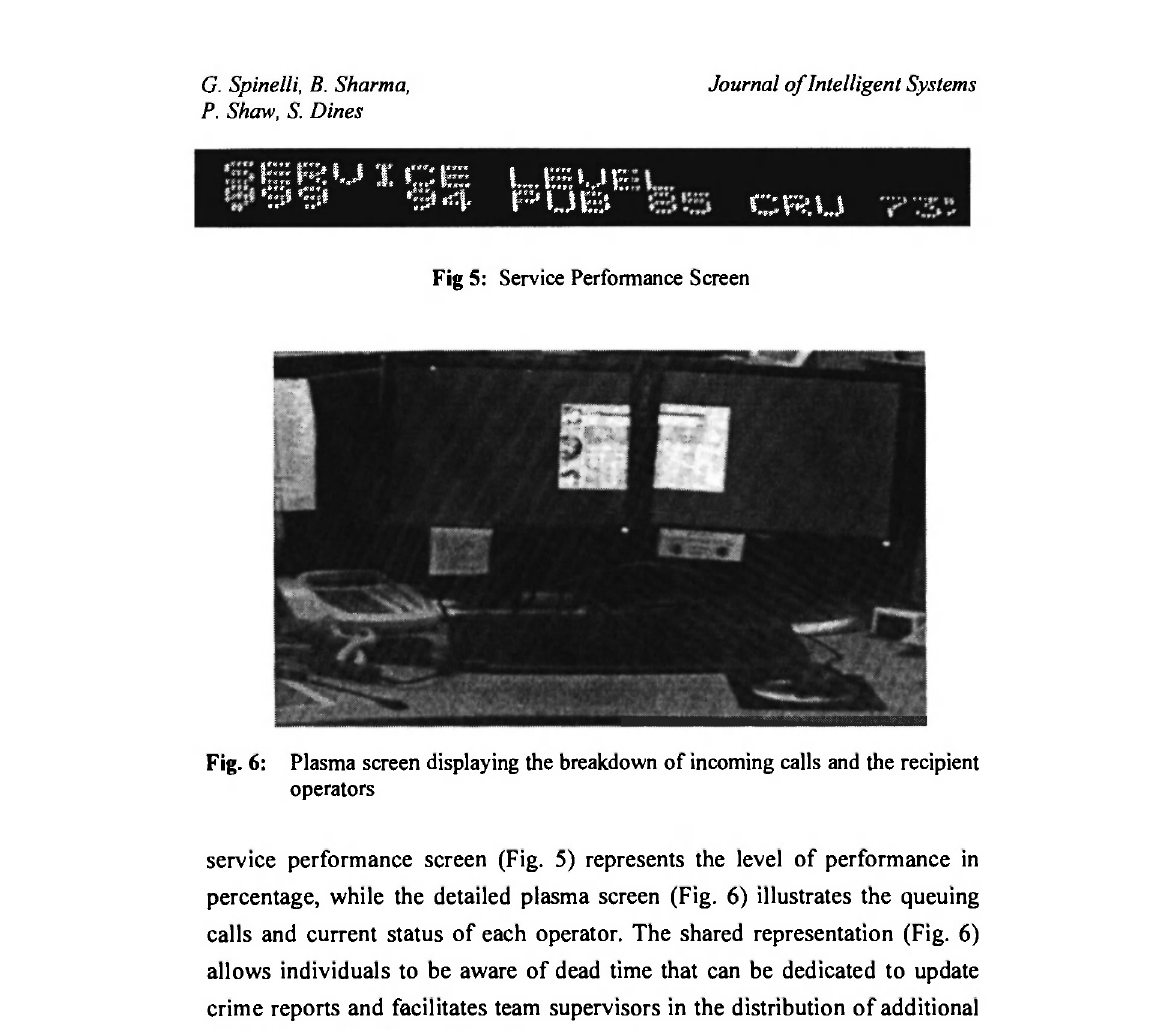
Fig. 6: Plasma screen displaying the breakdown of incoming calls and the recipient